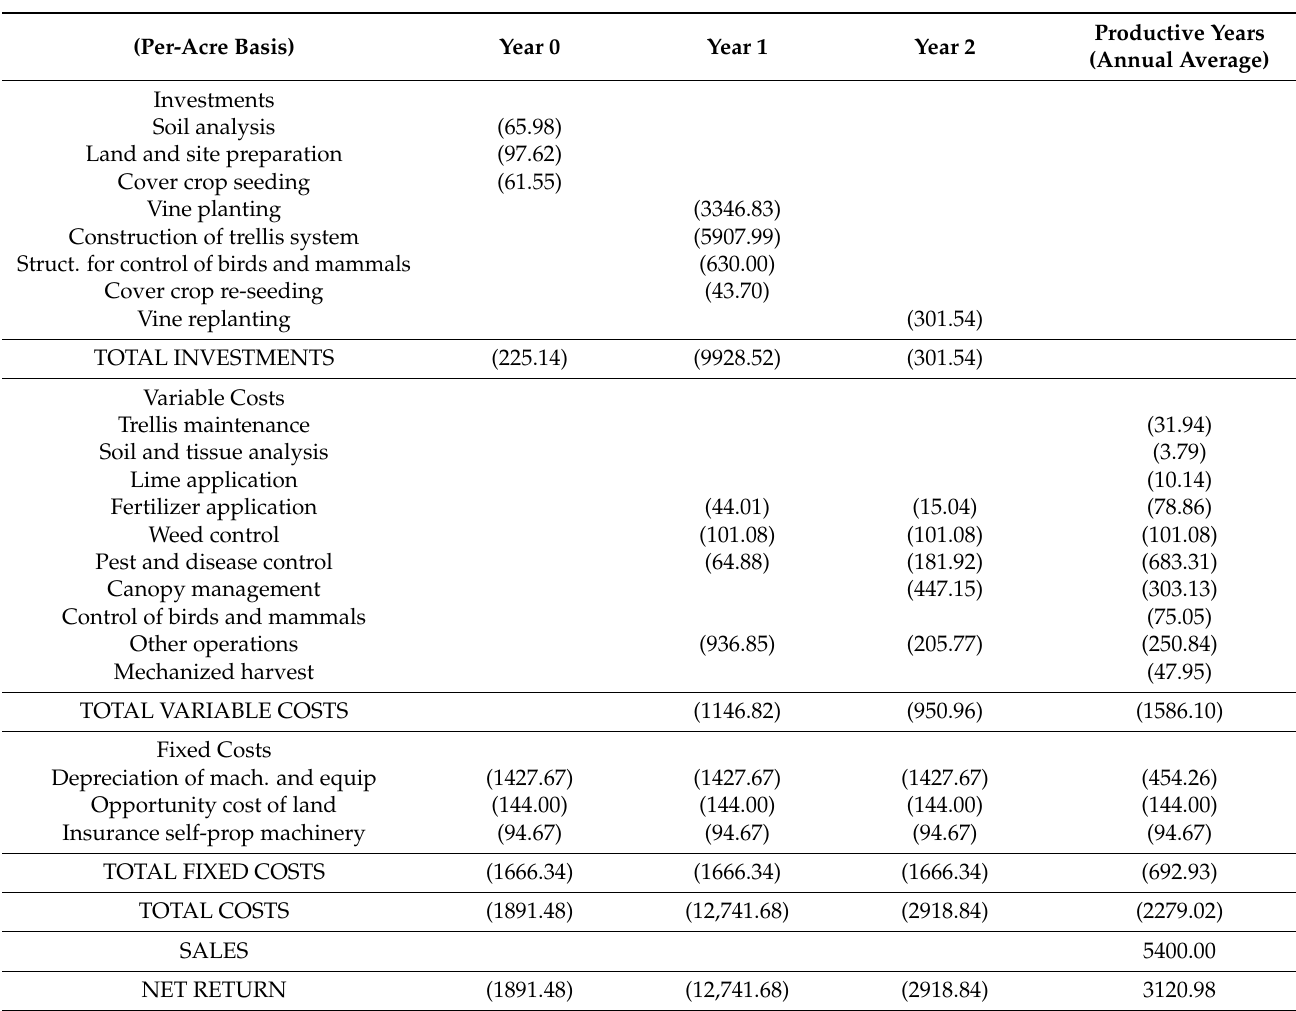
Table 8. Summary of budget items for a 30-acre Cabernet franc vineyard. Productive years from year 4